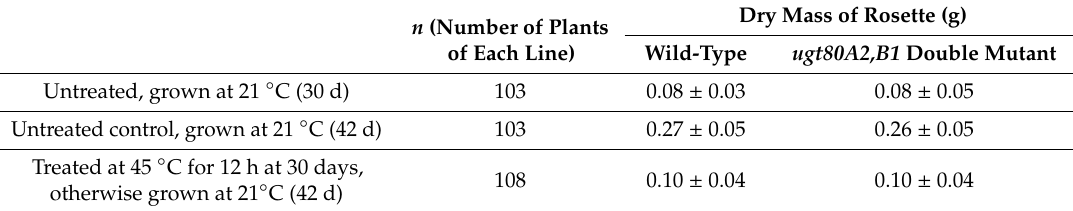
Table 2. Dry mass of rosettes of wild-type and ugt80A2,B1 plants in response to severe heat stress at 30 d of age. Dry masses of untreated rosettes were determined after harvest at 30 d and 42 d. Treated rosettes were harvested 12 d after the onset of a 12 h, 45 ◦ C heat treatment. The dry masses of wild-type and ugt80A2,B1 double mutant rosettes were not significantly di ff erent under any condition, as evaluated by Student’s t -test ( p < 0.05). Dry Mass of Rosette (g) n (Number of Plants of Each Line) Wild-Type ugt80A2,B1 Double Mutant Untreated, grown at 21 ◦ C (30 d) 103 0.08 ± 0.03 0.08 ± 0.05 Untreated control, grown at 21 ◦ C (42 d) 103 0.27 ± 0.05 0.26 ± 0.05 Treated at 45 ◦ C for 12 h at 30 days, 108 0.10 ± 0.04 0.10 ± otherwise grown at 21 ◦ C (42 d)